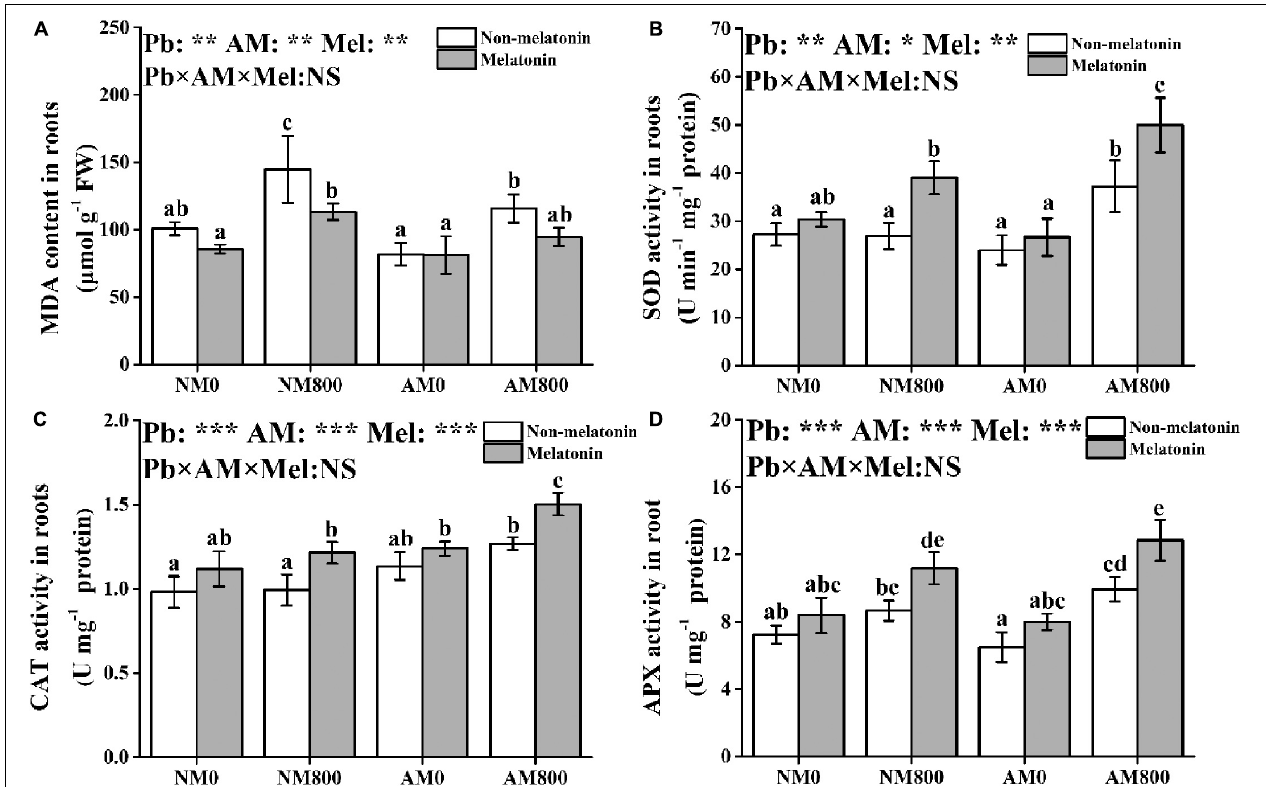
FIGURE 4 | (A–D) The MDA contents, SOD activity, CAT activity, and APX activity of AM roots under Pb stress and melatonin application. The data are the means ± standard deviation ( n = 4). Different letters above the columns indicate significant difference among the means of MDA content or antioxidant